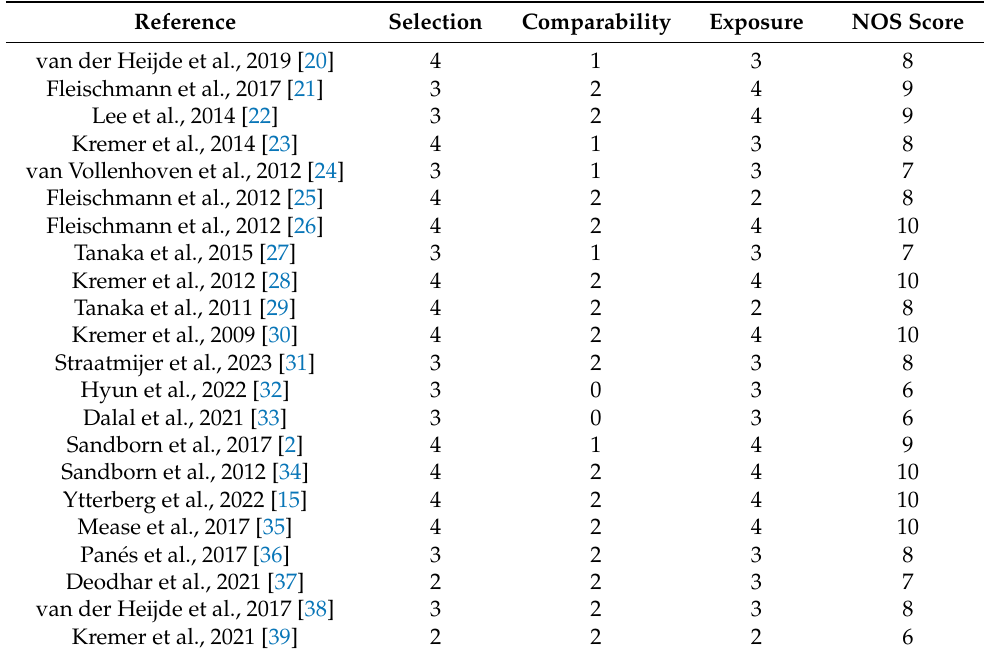
Table 2. Quality of the studies reported in the 22 selected articles, according to the Newcastle–Ottawa scale